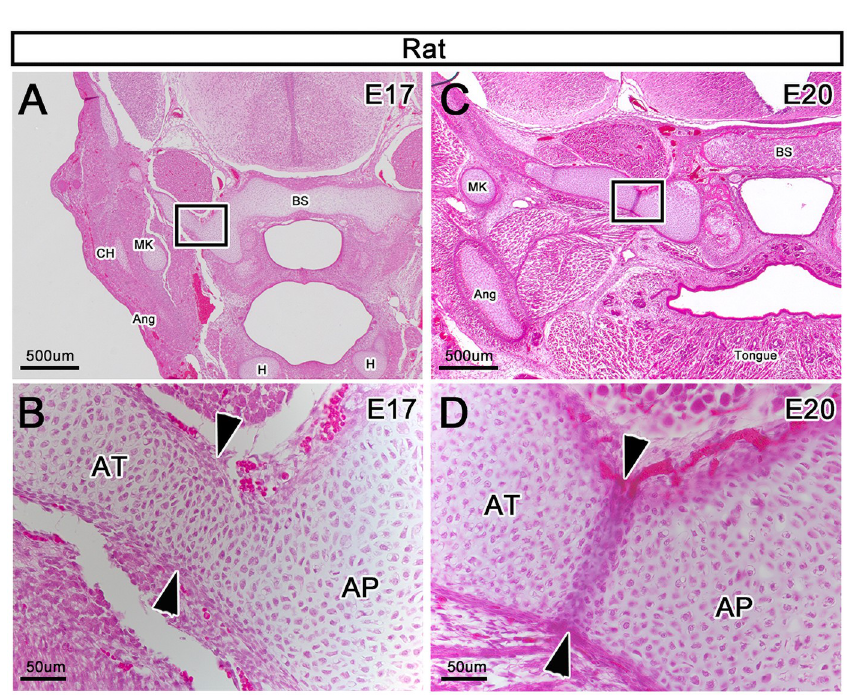
Fig 8. A-A connection in rats. (A and B) Frontal sections at E17. (C and D) Frontal sections at E20. (B and D) Enlargement of (A and C), respectively. (B) The AP is continuous with the AT at E17 (arrowheads). (D) The AP is separated from the AT by a thick perichondrium at E20 (arrowheads). Ang, angular process; AP, alar process; AT, ala temporalis; BS, basisphenoid; CH, condylar head; H, hyoid bone; MK, Meckel’s cartilage.